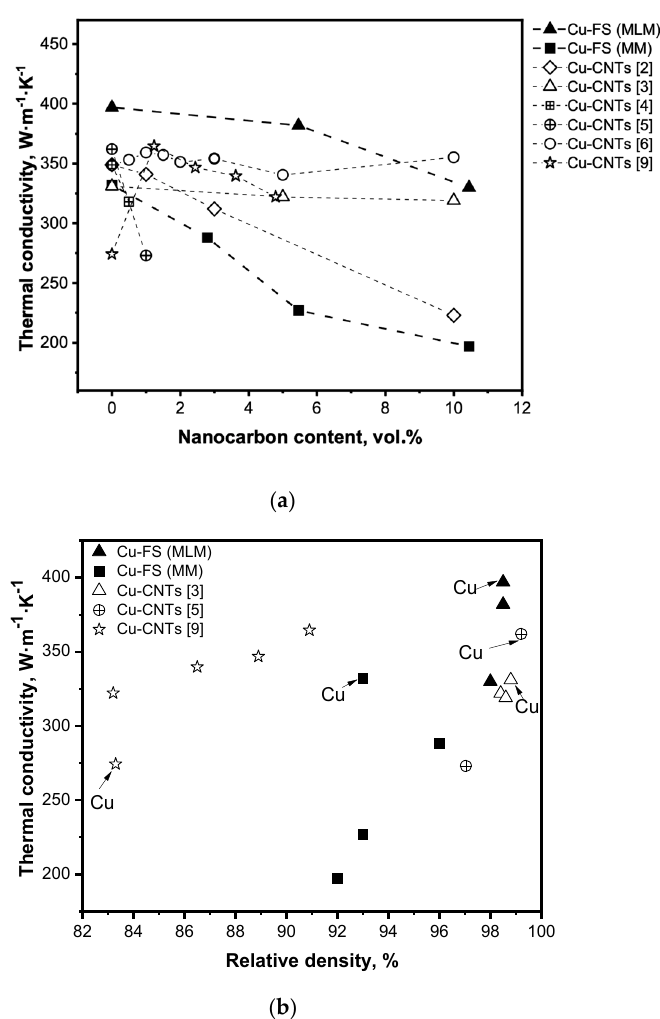
Figure 4. The dependences of thermal conductivity on the nanocarbon content ( a ) and the composites density ( b ) for the Cu-FS composites produced in the present work and for Cu-CNTs composites [3,5,9].